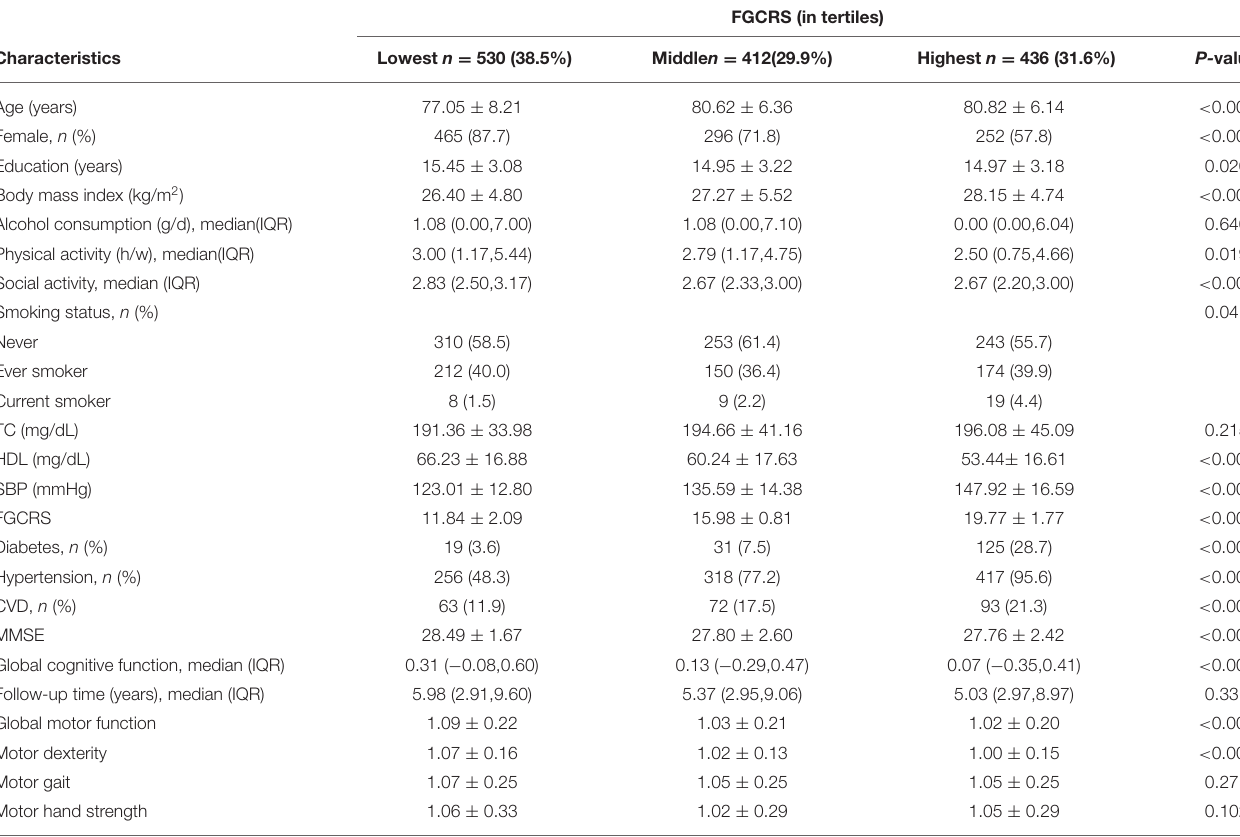
TABLE 1 | Baseline characteristics of the study population by Framingham General Cardiovascular Risk Score (FGCRS) categories ( n = 1,378) *